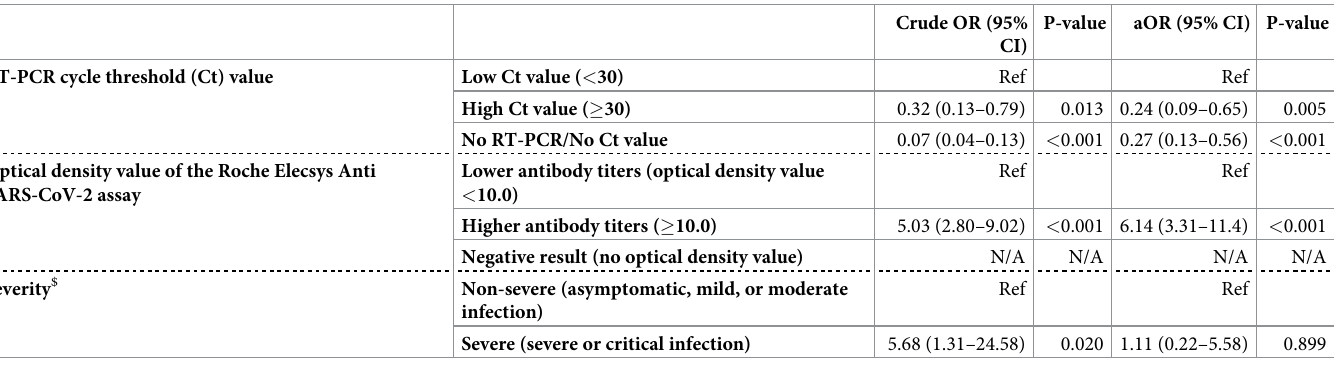
Table 3. Results of univariable and multivariable logistic regression, assessing the association between seropositivity using the BioMedomics COVID-19 IgM/IgG Rapid Test and the following covariates: RT-PCR Ct value (cut-off at 30), Elecsys optical density value, and severity of infection.